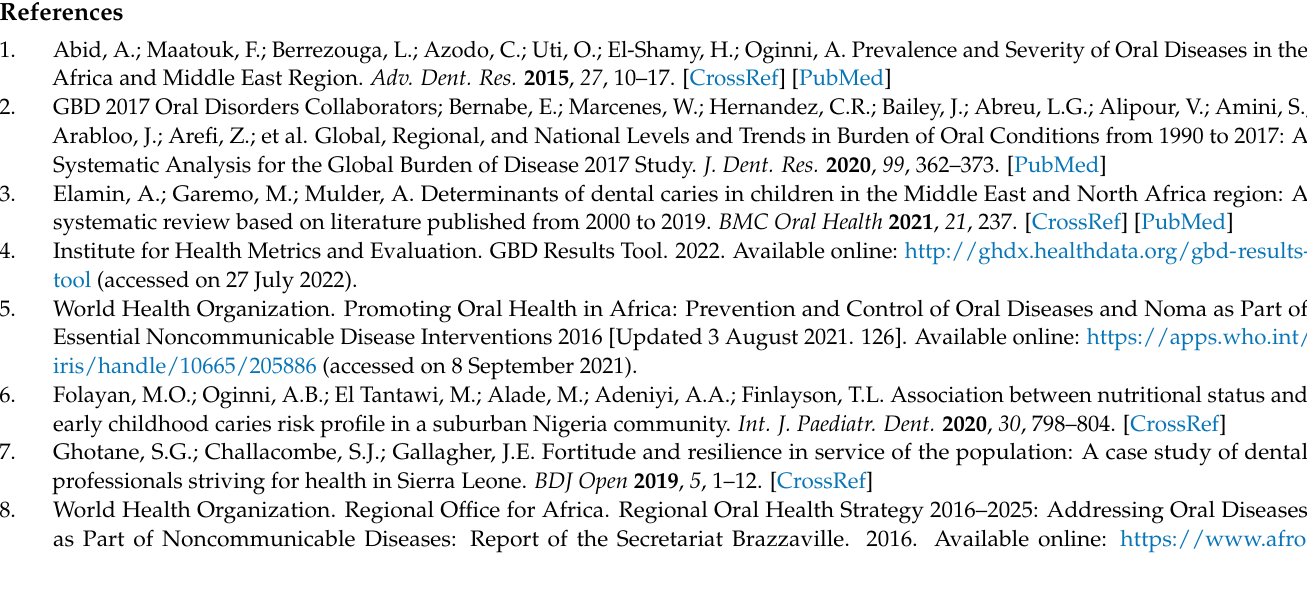
World Health Organization. Regional Office for Africa. Regional Oral Health Strategy 2016–2025: Addressing Oral